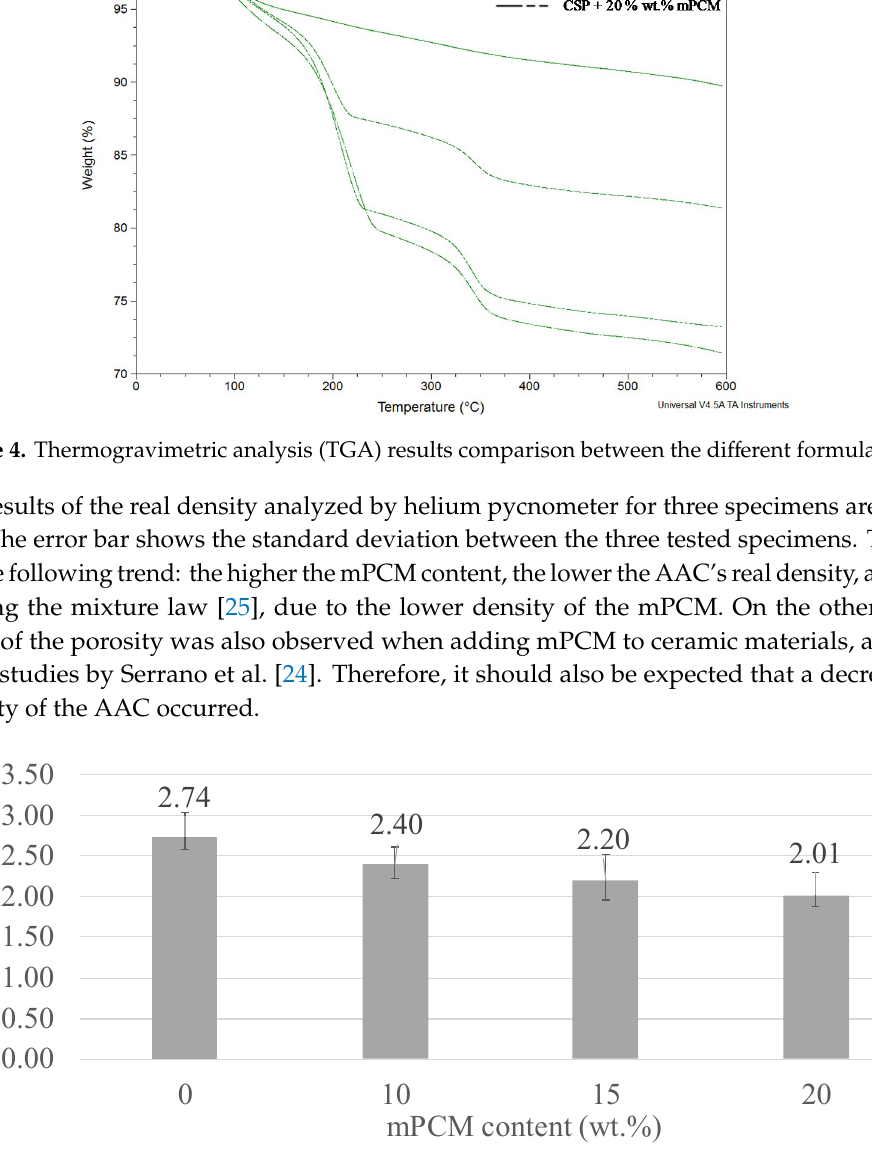
Figure 5. Density results for the different formulations.